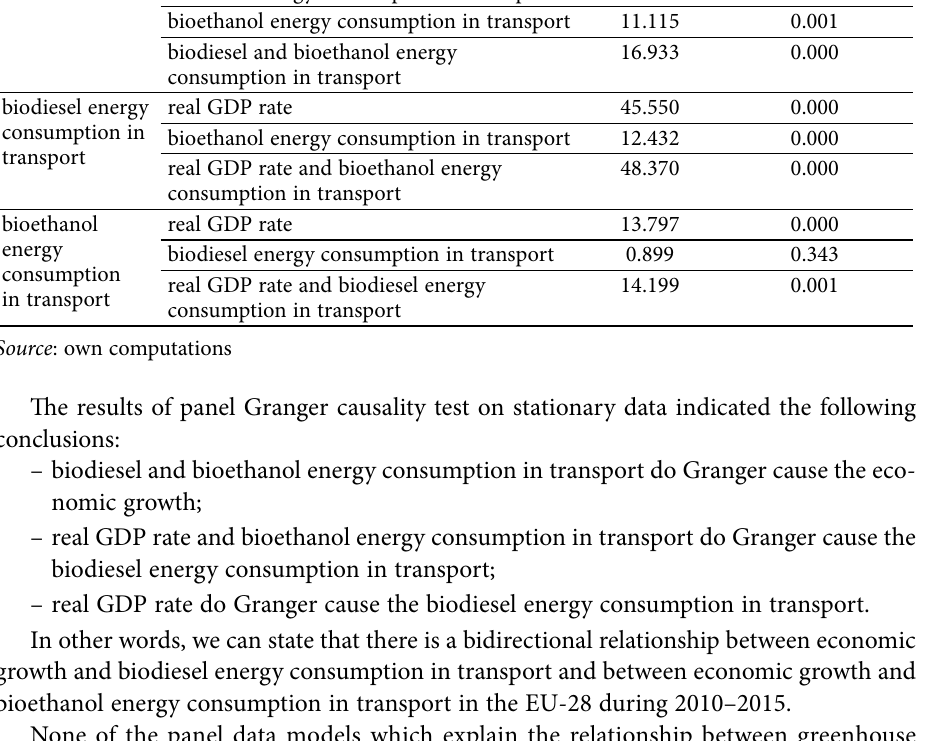
Table 5. Panel VAR-Granger causality Wald test for economic growth, biodiesel and bioethanol energy consumption in transport in the EU-28 countries during 2010–2015 Effect